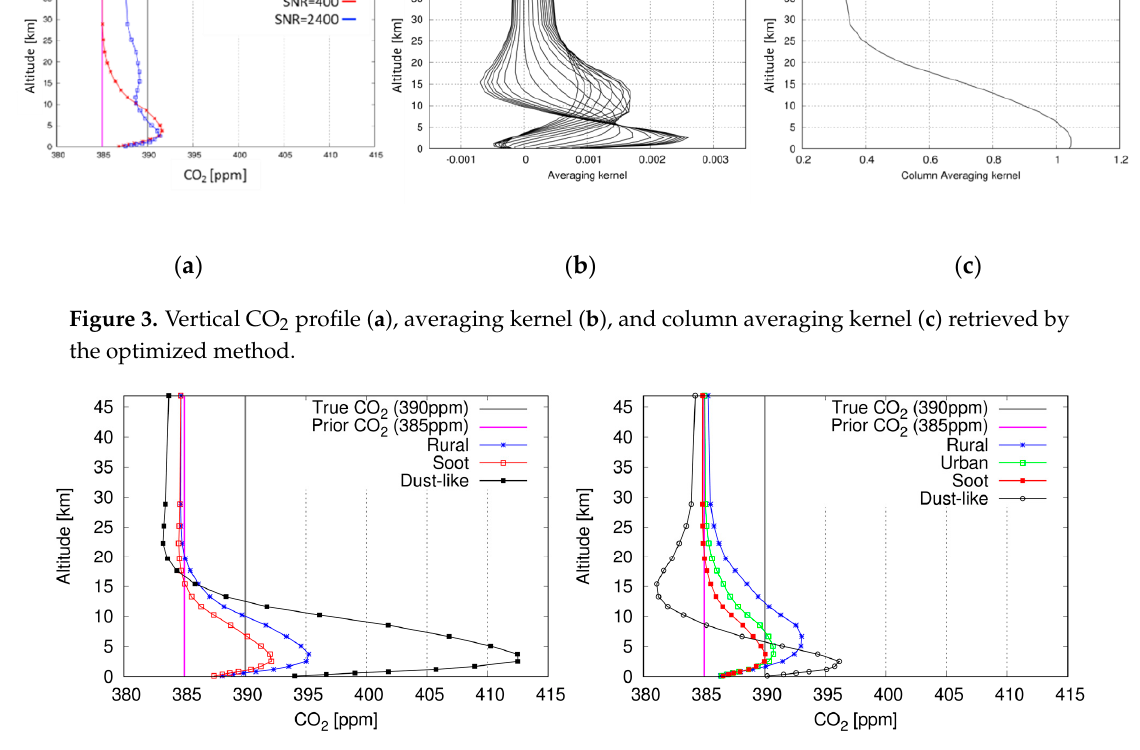
Figure 4. CO 2 profiles retrieved using the original method ( left ) and the optimized method ( right ) assuming AOT of 1.0 at 0.55 μ m for the atmosphere, including Rural (blue), Urban (green), Soot (red), and Dust-like (black) aerosol types. Surface albedos are 0.2 for all GOSAT measurement bands.